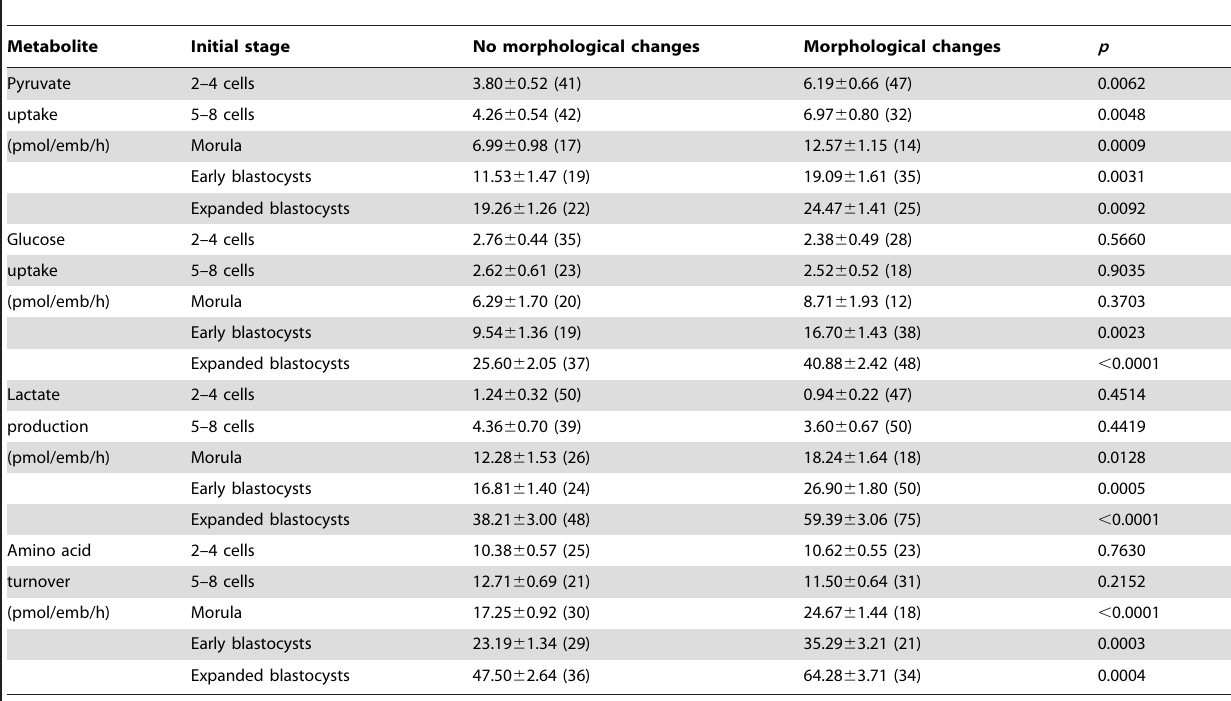
Table 2. Comparison of mean values of metabolites consumed or produced in culture media between embryos with or without evidences of morphological changes after 24 hours of individual